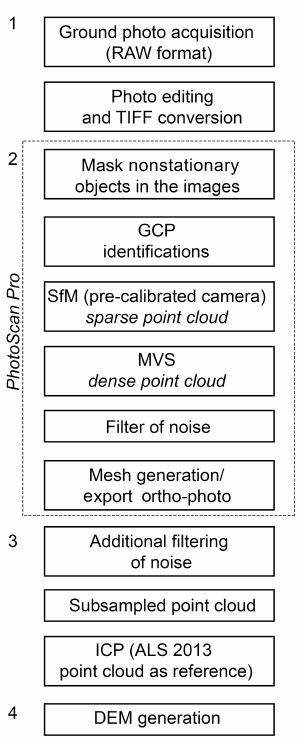
Figure 4. Workflow illustrating the photo-based 3-D reconstruction process used in this work for both case studies, starting from image collection through the DEM